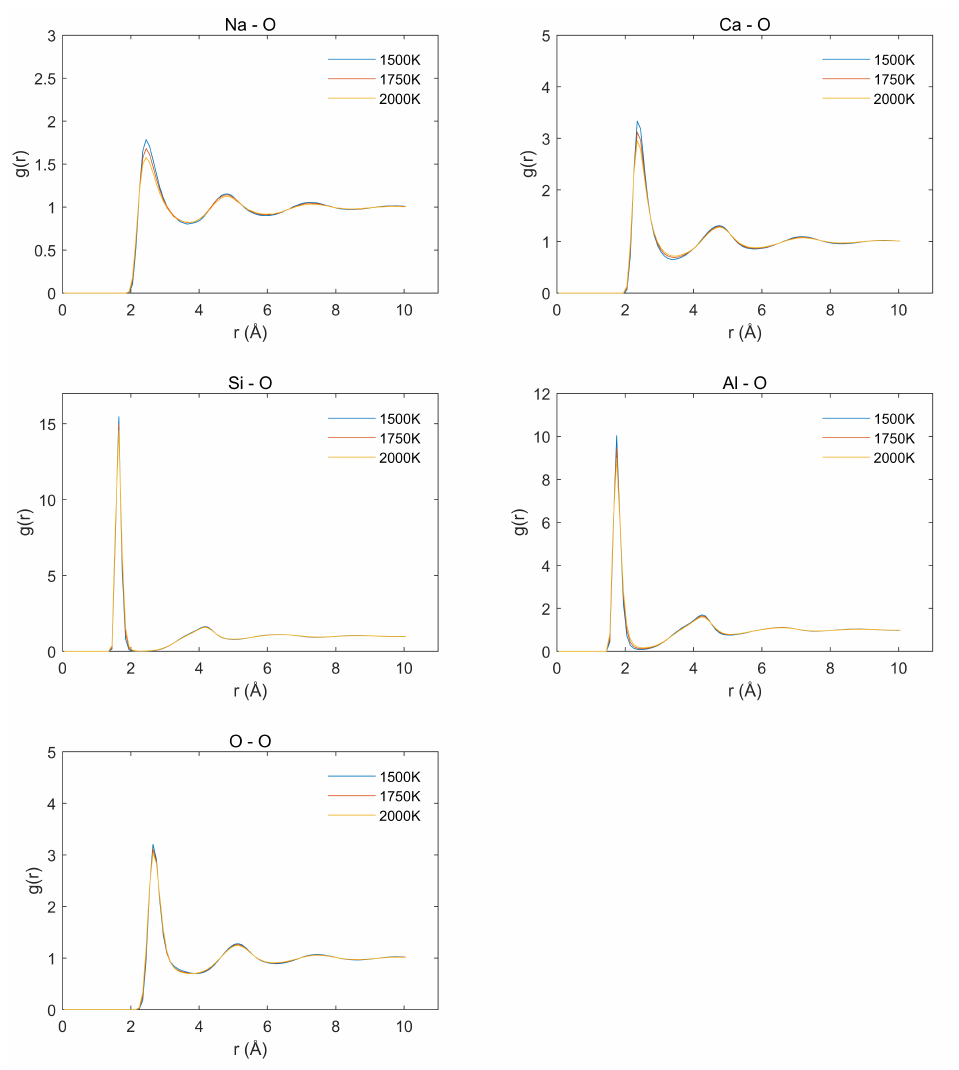
Figure 8. Radial pair distribution functions g ( r ) of various pairs of atoms for Na 2 O–CaO–Al 2 O 3 –SiO 2 systems with 8 wt% Na 2 O at different